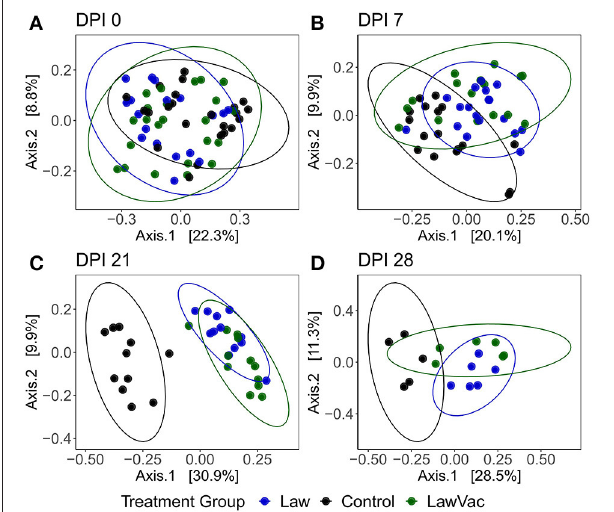
FIGURE 6 | Principal coordinate analysis plots using the Bray–Curtis dissimilarity of fecal microbiota among Control, Law, and LawVac groups at (A) 0 days post-infection; (B) 7 days post-challenge; (C) 21 days post-infection; and (D) 28 days post-infection. Ellipses represent the 95% confidence level of the multivariate Student’s t